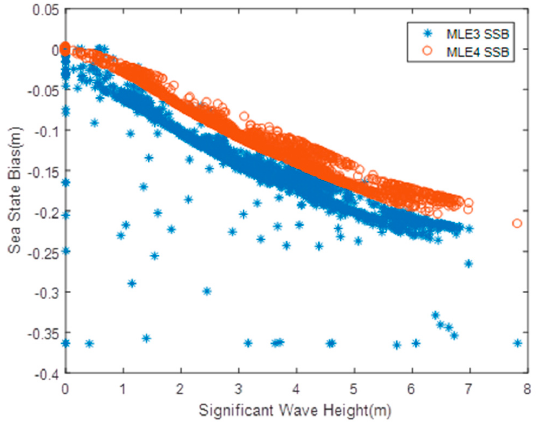
Figure 5. Sea state bias (SSB) difference with respect to Significant Wave Height.